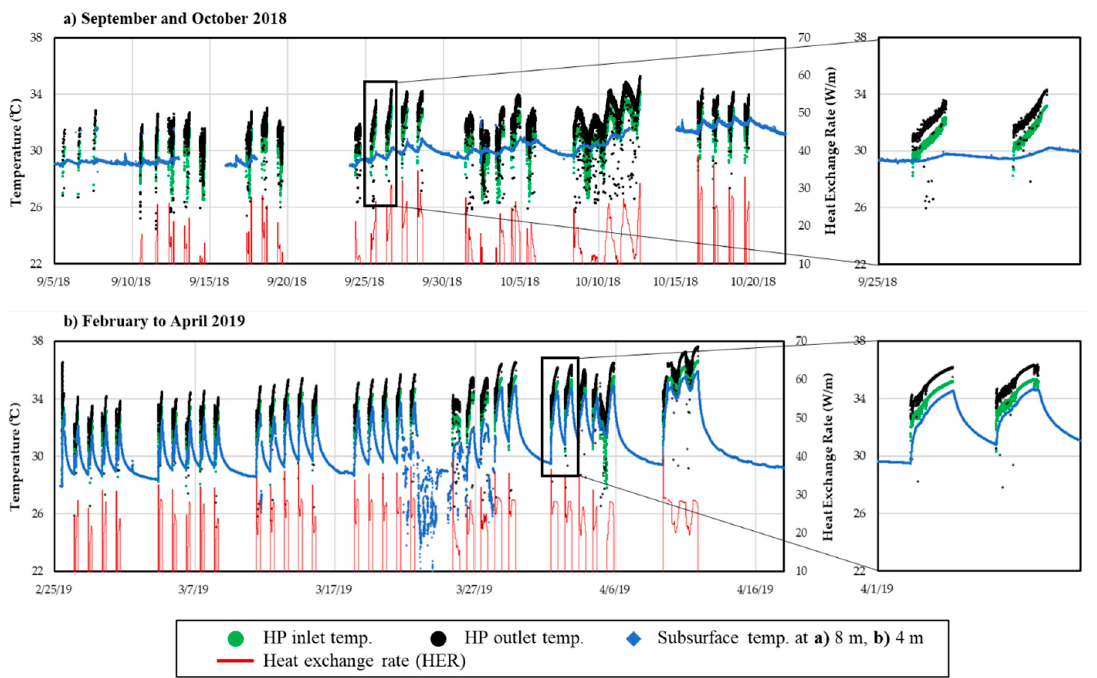
Figure 6. The measurement results for the operational experiment: ( a ) September to October 2018; ( b ) February to April 2019.